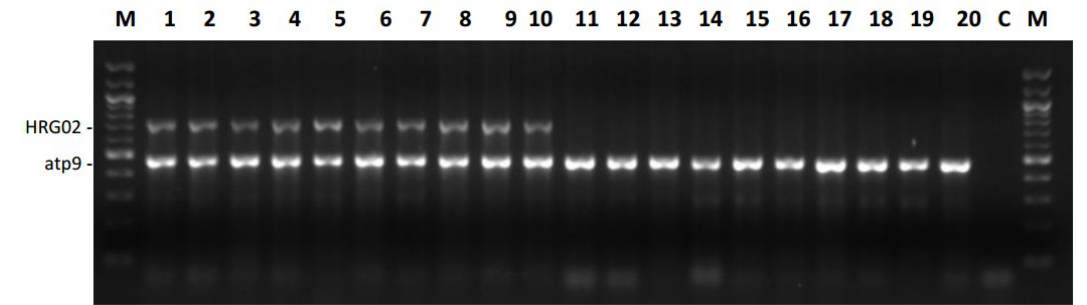
Figure 7. Marker HRG02 for the fertility restorer gene Rf1. Marker HRG02 (derived from Y10) for the restorer Rf1 was analyzed combined with primers for atp9 used as internal control. 1 = RHA 273, 2 = RHA 294, 3 = RHA 298, 4 = RHA 311, 5 = RHA 325, 6 = RHA 354, 7 = RHA 363, 8 = RHA 376, 9 = RHA 396, 10 = RHA 858, 11 = HA 228, 12 = HA 249, 13 = HA 285, 14 = HA 288, 15 = HA 307, 16 = HA 319, 17 = HA 320, 18 = HA 425, 19 = HA 442, 20 = HA 446, C = negative control, M = 100 bp marker New England BioLabs ® . Table 6. Specificity of molecular markers used for detection of fertility restoration in the sunflower association panel.